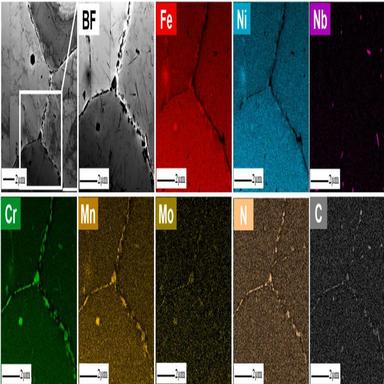
Characterization of Alloy 709 crept at 700 ◦C. The EDX maps show carbide-nitride precipitates rich in Cr and Mn are nucleated along the grain boundaries after the creep test.